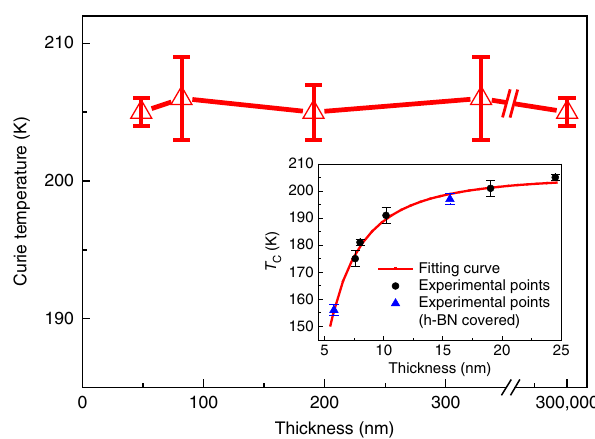
Fig. 2 Thickness dependence of the Curie temperature ( T C ). Excepting the device with a thickness of 329 nm, the T C s of the devices were determined by the temperature point when the remanence becomes zero. The error bar is determined by the noise level around the point when the remanence becomes zero (Supplementary Fig. 8). The T C of the device with a thickness of 329 nm was determined from its ρ xx ( T ) curve. Inset shows the thickness dependence of the T C s in nano fl akes with thicknesses from 5.8 to 25 nm with fi tting curve. Blue dots are the T C s for the two ultra-clean devices that were covered by h-BN and PMMA in a glove box (O 2 <0.1 p.p.m. and H 2 O <0.1